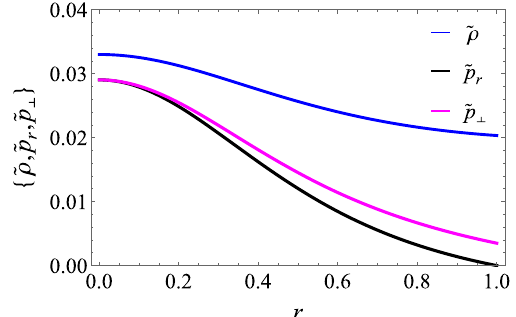
Fig. 1 Decreasing behavior of density and pressures of the anisotropic solution